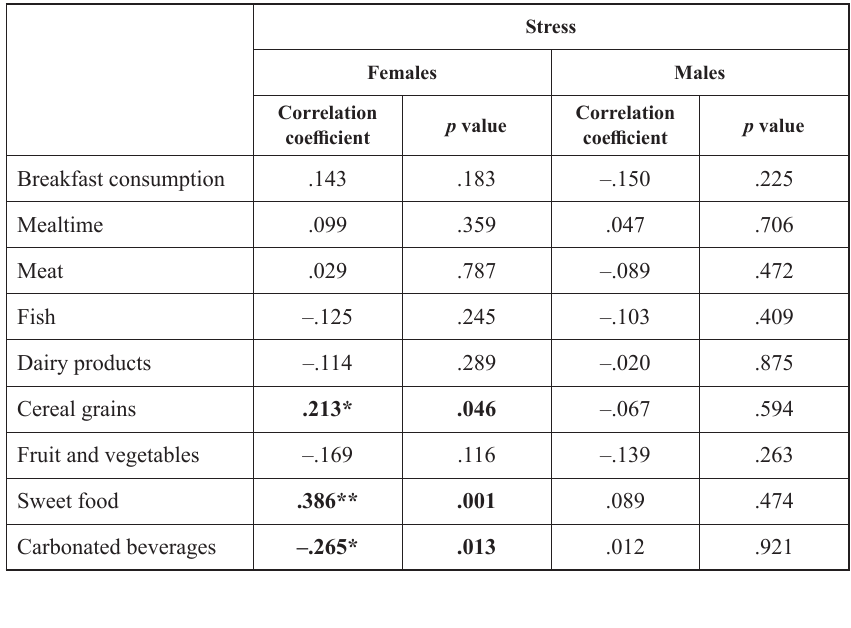
Table 3. Interrelationship between harmful habits and perceived stress among